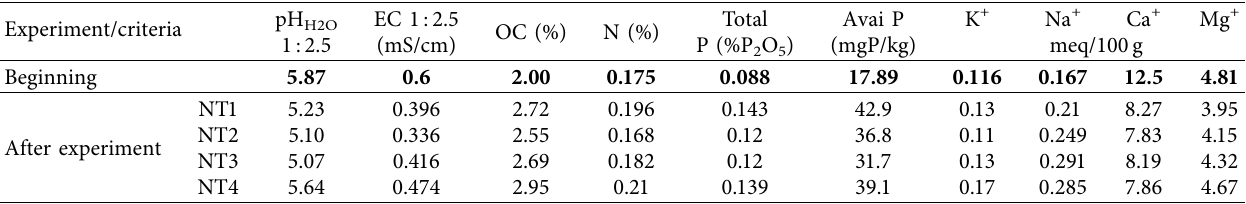
After experiment